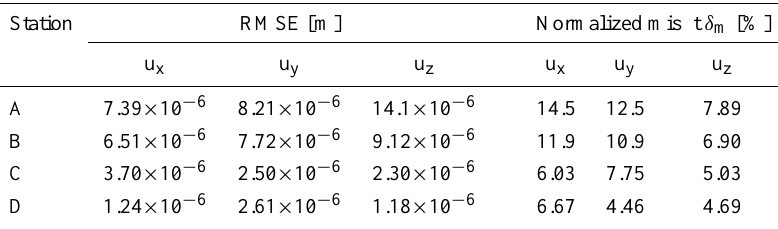
Table 3. Performance indexes RMSE and normalized misfits δ m for four stations located near (A and B in Fig. 2) and far (C and D in Fig. 2) from the summit of